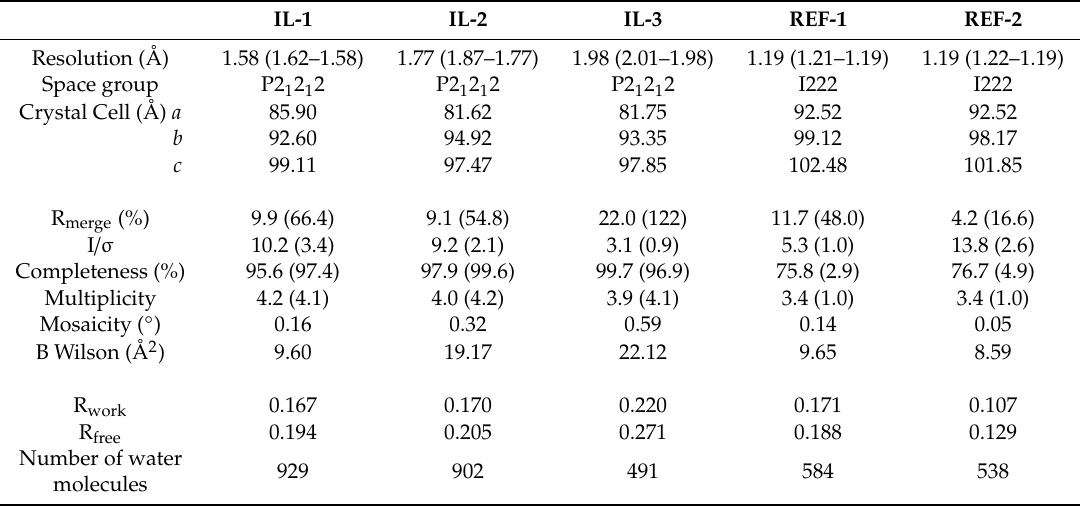
Table 1. Crystallographic parameters of glucose isomerase (GI) crystals grown on IL-HCMs (IL-1,2,3) and, for comparison, without them (REF 1,2), by using the same crystallization condition. Values in parenthesis refer to the outer resolution